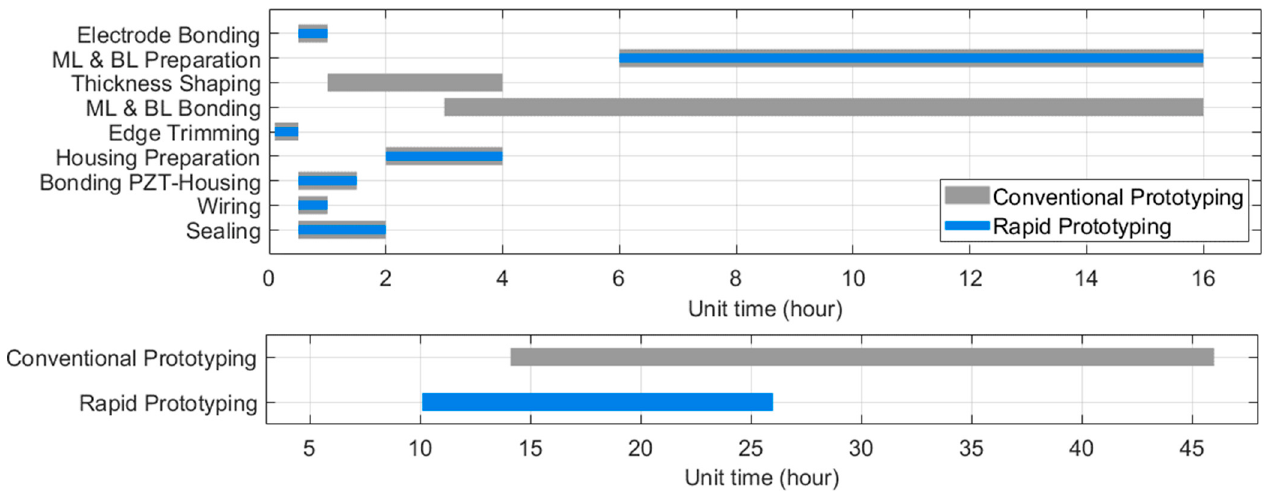
Figure 9. Comparison of estimated manufacturing time of the rapid prototyping method vs. conventional prototyping methods: required time range for each stage ( upper ) and in total ( lower ).